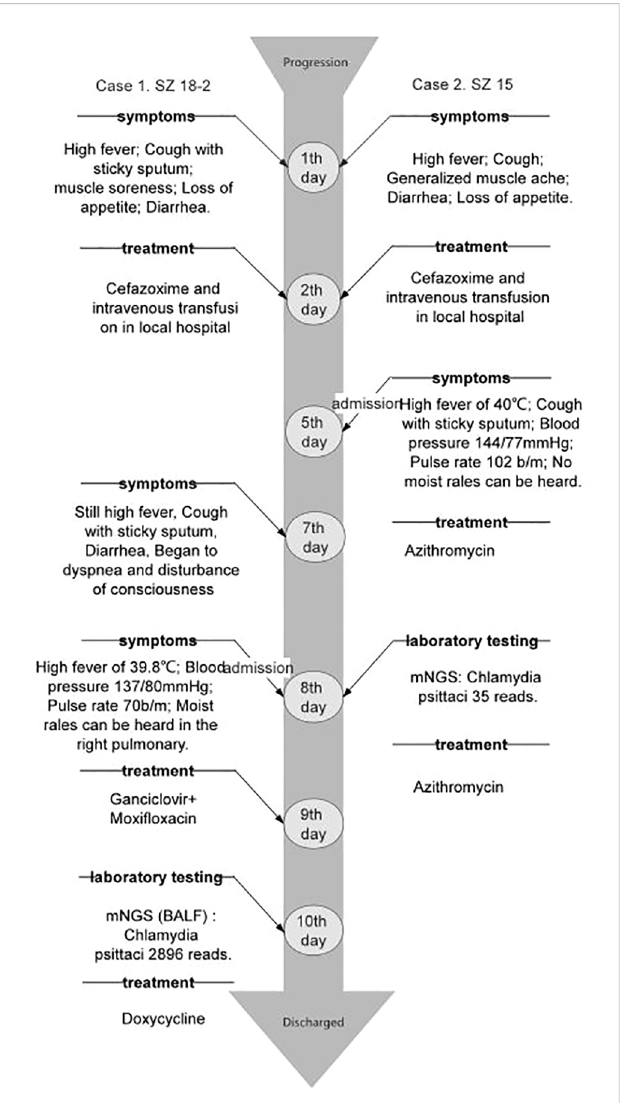
FIGURE 3 The timeline of disease progression and treatment of the two